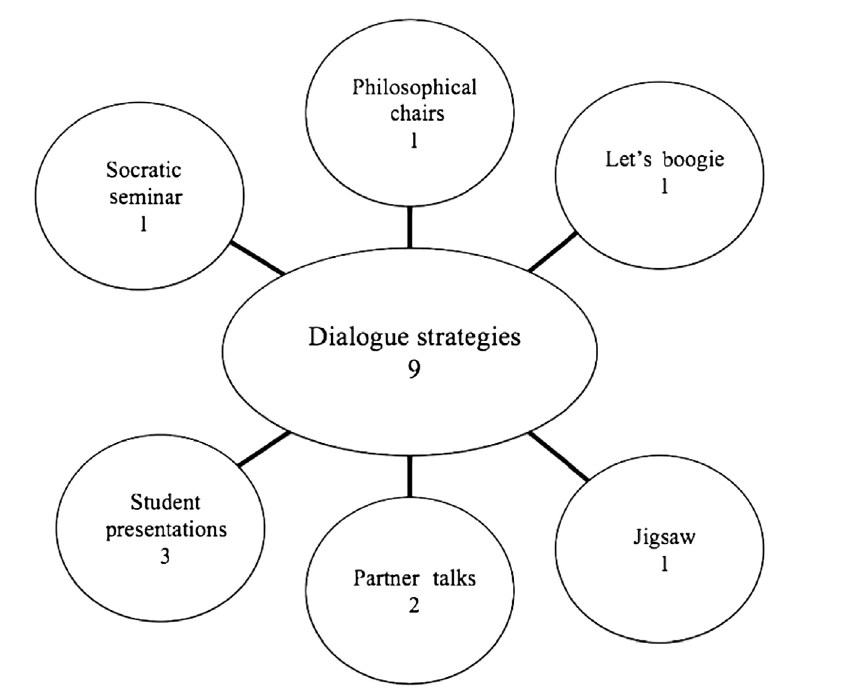
Figure 4: Dialogue strategies that teachers identified utilizing